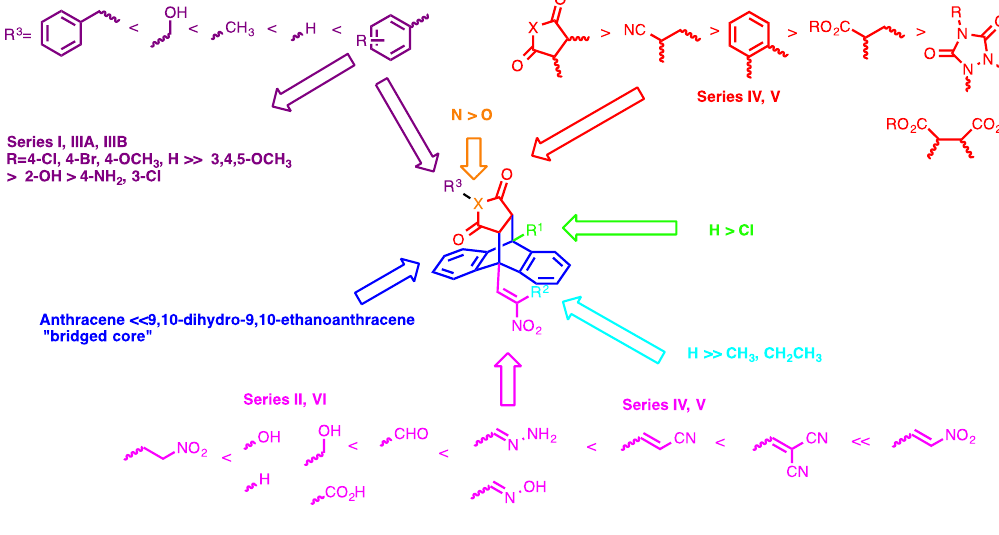
Figure 9. Summary of SAR for 9,10-dihydro-9,10-ethanoanthracenes.